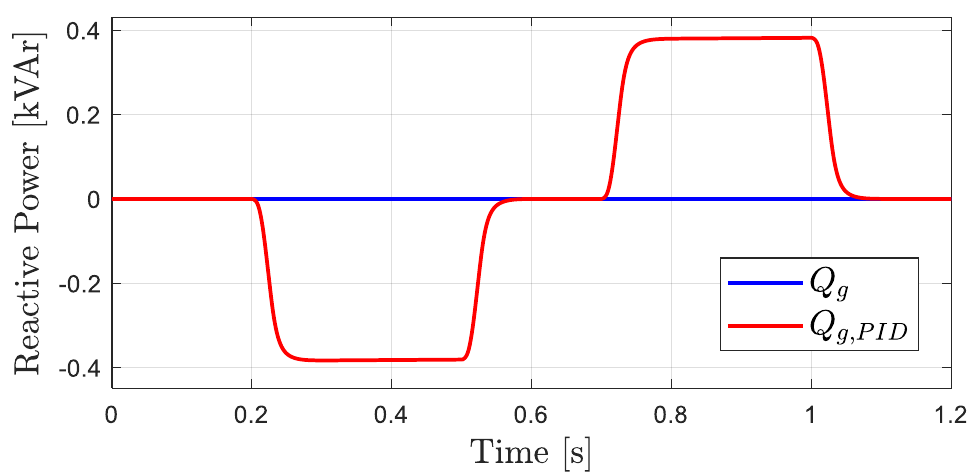
Figure 12. Reactive power to the grid time profile comparison.